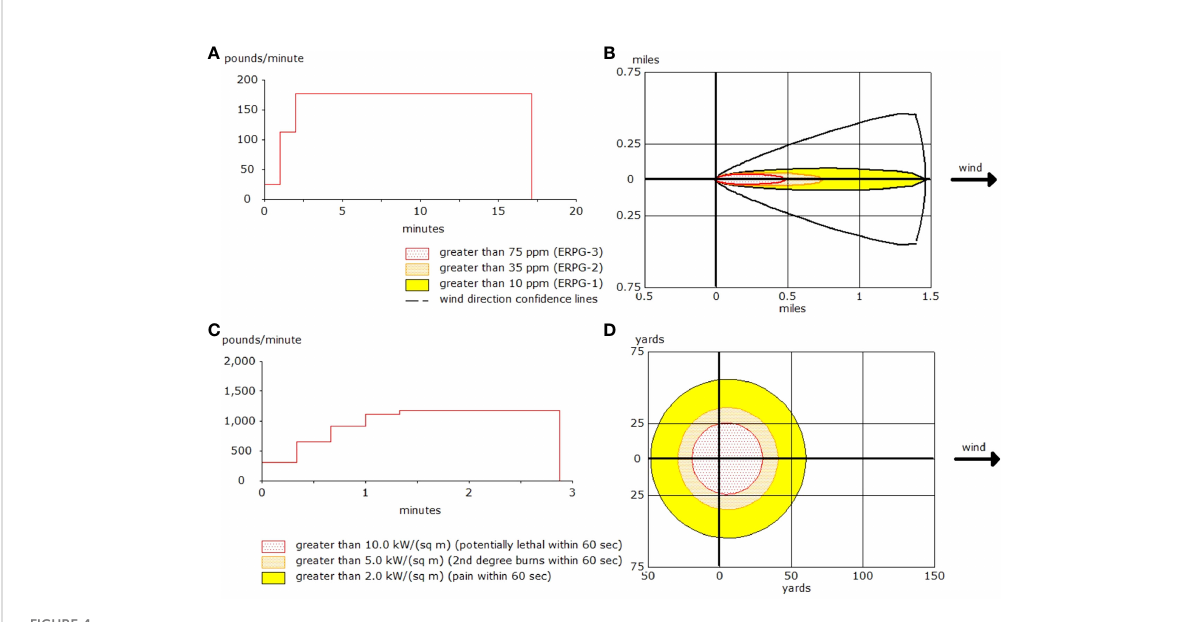
FIGURE 4 Prediction results of ALOHA. Plots show the predicted averaged release rate (A) and the toxic threat zones (B) if the ACN is not burning and forms an evaporating puddle, and the predicted averaged burn rate (C) and thermal radiation threat zones (D) if the ACN is burning and forms a pool fi